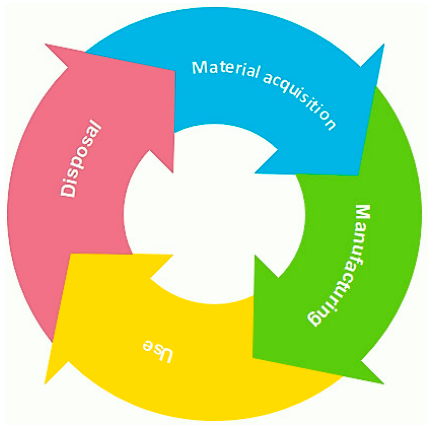
Figure 11. Life cycle phases [157].